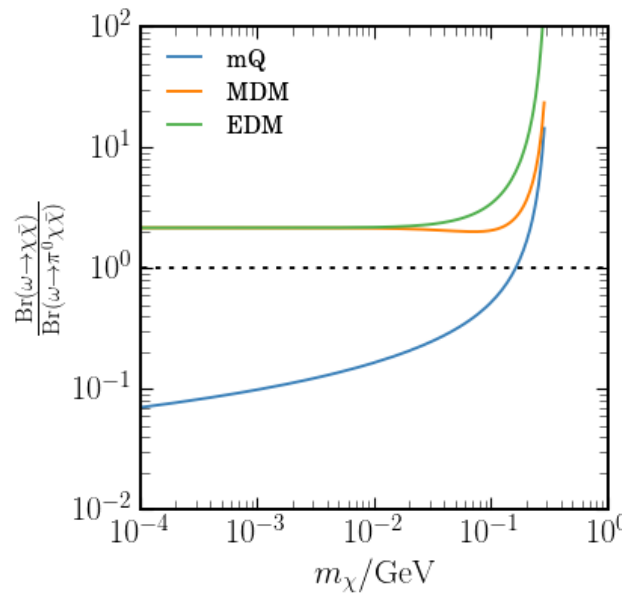
Figure 5: The ratio of the two branching ratios for the ω meson’s two main de- cay channels involving a dark pair, as given by equations (14) and (17). For the dimension-5 operators, MDM and EDM, the decay involving a pion is always at least marginally subdominant, whereas for mQ there are dark state masses for which the 3-body decay is